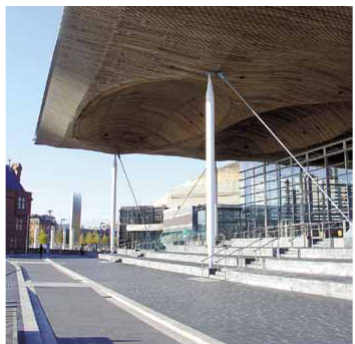
18 pav. Nacionalinės Velso asamblėjos eksterjeras, Kardifo įlanka, Jungtinė Karalystė, archit. R. Rogers, 2006 m. Fig. 18. The National Assembly of Wales, exterior view, Cardiff bay, United Kingdom, archit. R. Rogers, 2006